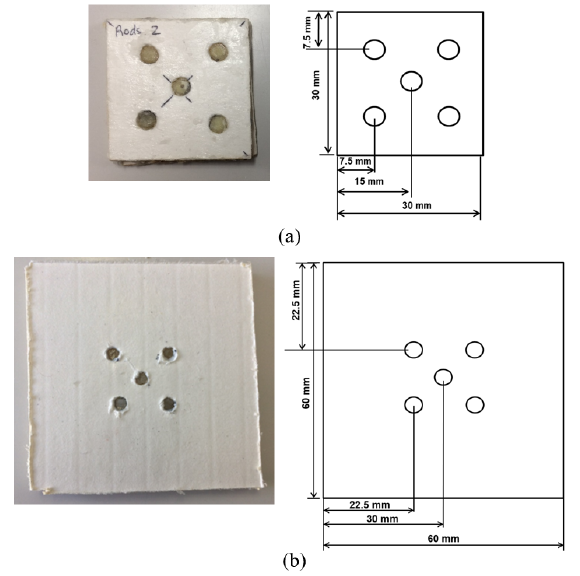
Figure 2: Dimensions and positions of rods in: (a) 30 mm × 30 mm cardboard panels; (b) 60 mm × 60 mm cardboard